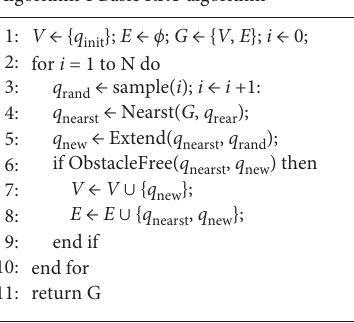
Figure 2: The two-layered model architecture. Algorithm 1 Basic RRT algorithm